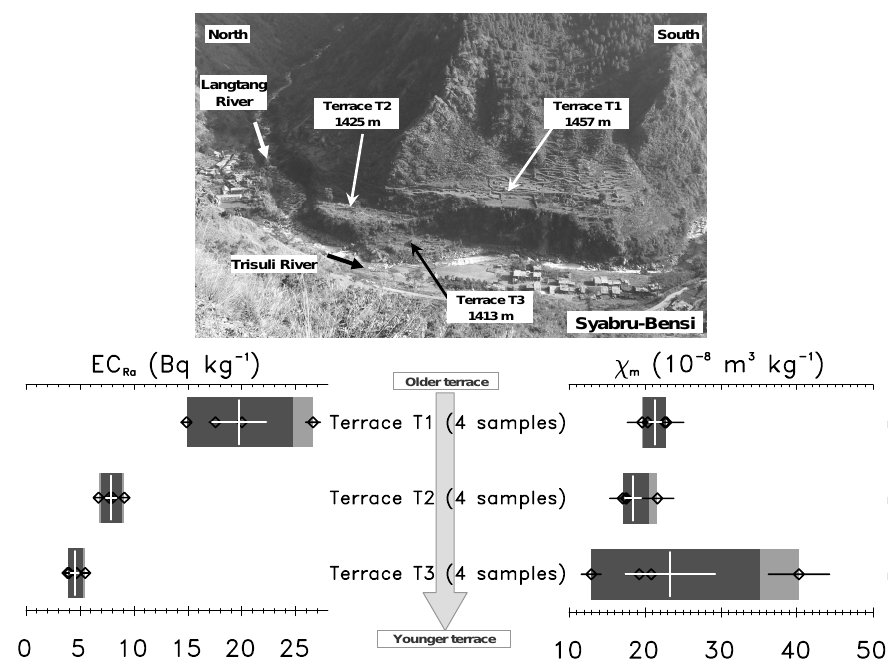
Fig. 4. Results of χ m and EC Ra on three imbricated river terraces, Syabru-Bensi, Nepal. A view of the terraces on the left bank of the Trisuli River in Syabru-Bensi is shown above the